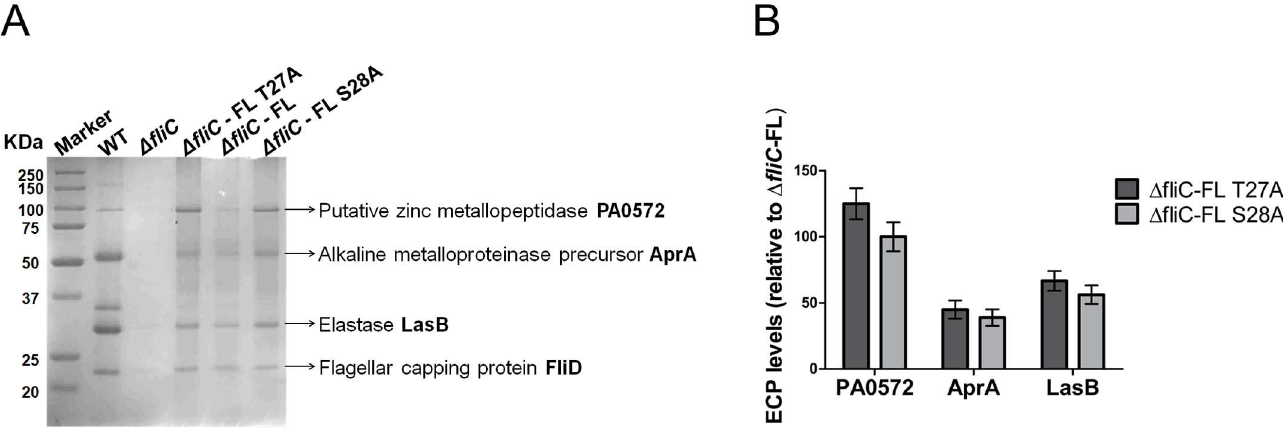
Fig 5. FliC phosphorylation affects type 2 secretomelevels in static biofilms. (A) Type 2 secretome analysisfor static biofilms of PAO1 WT, Δ fliC , Δ fliC -FL T27A, Δ fliC -FL and Δ fliC -FL S28A strains grown in 6-well plate for 24 h. Experiment was conductedwith three biologicalreplicatesand two technical replicateseach. (B) Quantification of proteases from (A) by Image J 1.43 software (http://rsbweb.nih.gov/ij/) showingincrease in representative T2SS proteasesof Δ fliC —FL T27A and Δ fliC —FL S28A. All differences are significant with student’s t-test p-values < 0.05.